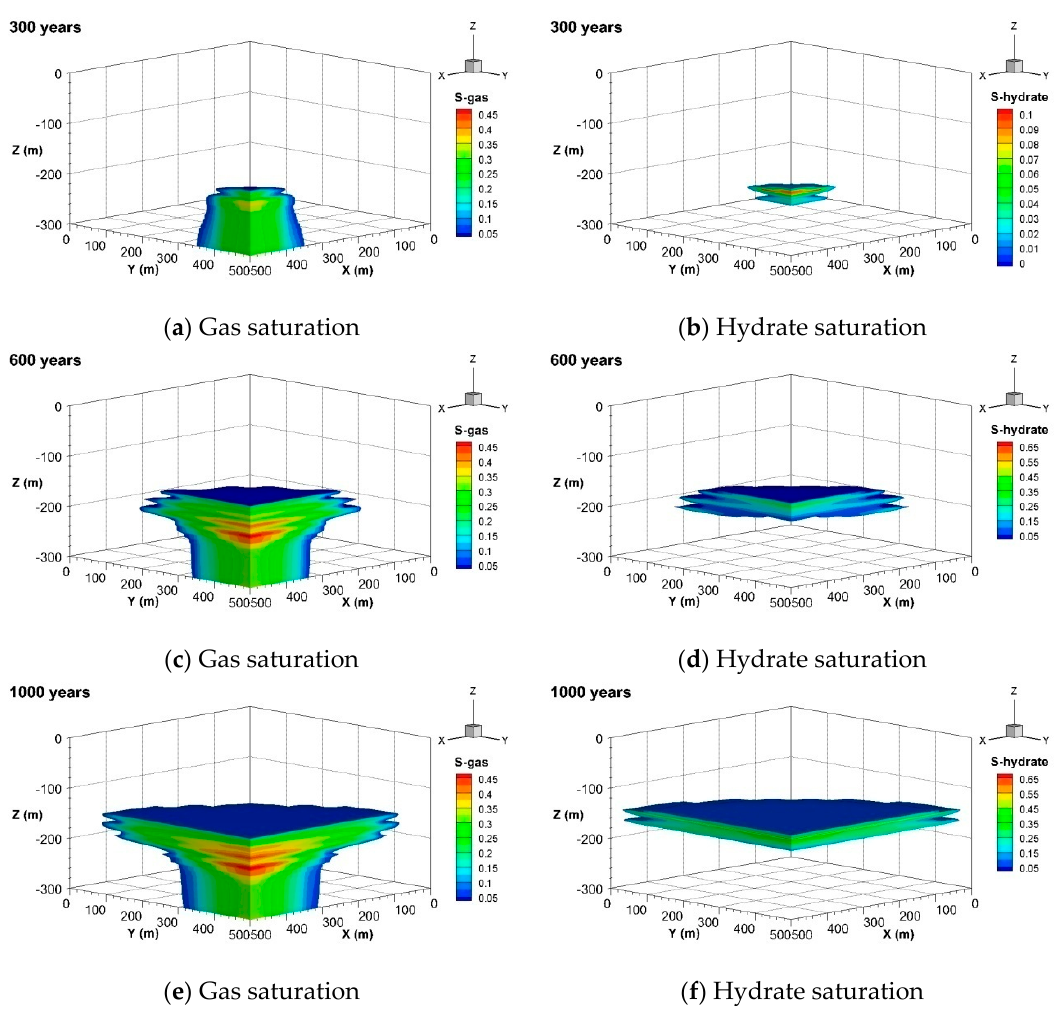
Figure 4. Gas and hydrate distribution at different simulated times (Case 1).